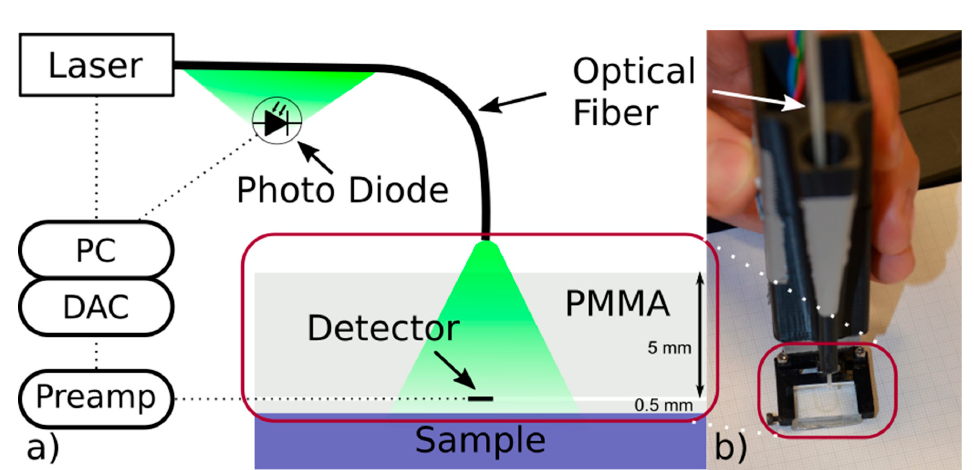
Figure 1. ( a ) Sketch of the optoacoustics (OA) setup. DAC: Data acquisition card, Preamp: Preamplifier. ( b ) Photograph of the probe. The laser injects 532 nm pulses into a fiber with a transparent jacket. A calibrated diode placed next to the fiber monitors the energy. The transparent detector is placed directly on the sample. Illumination is centered through the detector. The polymethyl methacrylate (PMMA) backing layer is 5 mm and the fronting layer 0.5 mm thick.